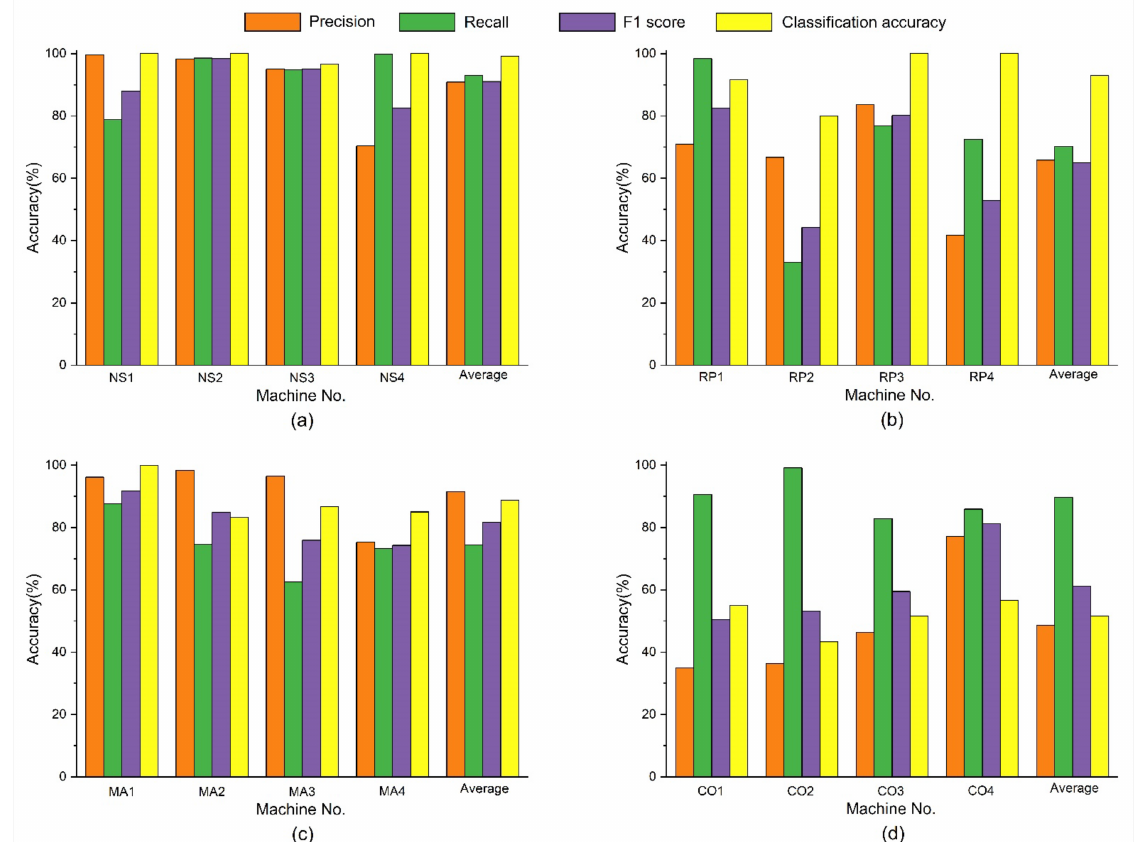
Figure 10. The segmentation performance metrics and fault classification accuracy of the trained model on the robustness test dataset: ( a ) NS; ( b ) RP; ( c ) MA; ( d )